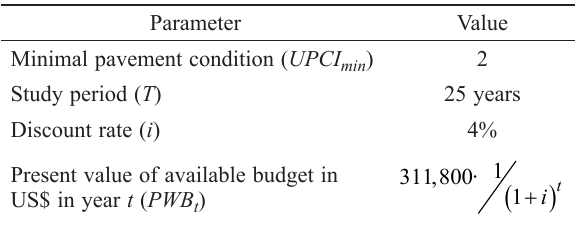
Table 5. Strategic level data considered in this study Parameter Value